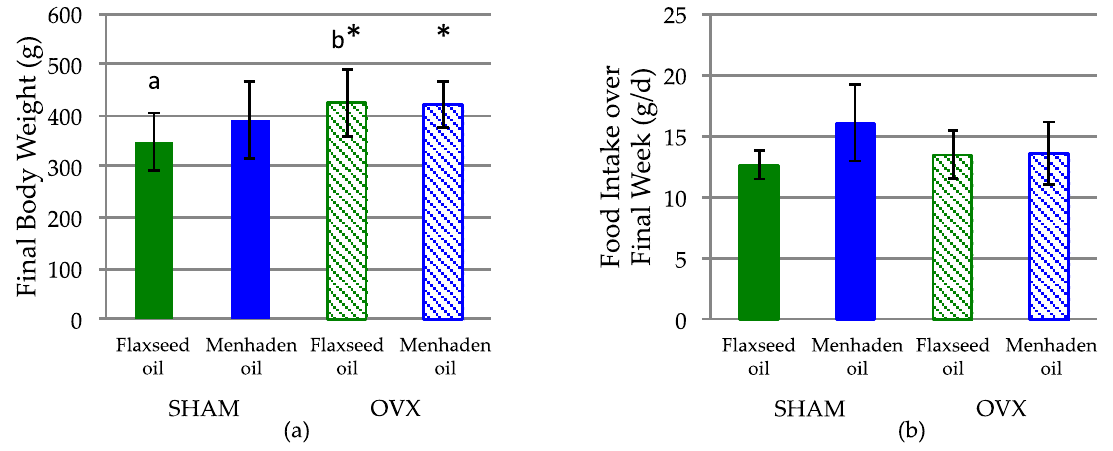
Figure 2. Final ( a ) body weight and ( b ) food intake of 6 ‐ month old SHAM and OVX rats randomized to diets with flaxseed oil or menhaden oil. A significant main effect of hormone status was observed for final body weight (* denotes a difference between both SHAM groups versus both OVX groups, p < 0.05). Within rats receiving a diet with flaxseed oil, rats randomized to OVX (424.67 ± 65.22 g) had significantly greater final body weight compared to SHAM (348.92 ± 57.51 g) (a versus b denotes a difference between these two groups fed flaxseed oil, p < 0.05). Within rats receiving a diet with menhaden oil, the body weight of rats randomized to OVX (422.17 ± 47.05 g) was not significantly different compared to SHAM (390.83 ± 75.82 g). No differences were observed among groups for food intake over the final week of the study period. All data are expressed as Mean ± SD.